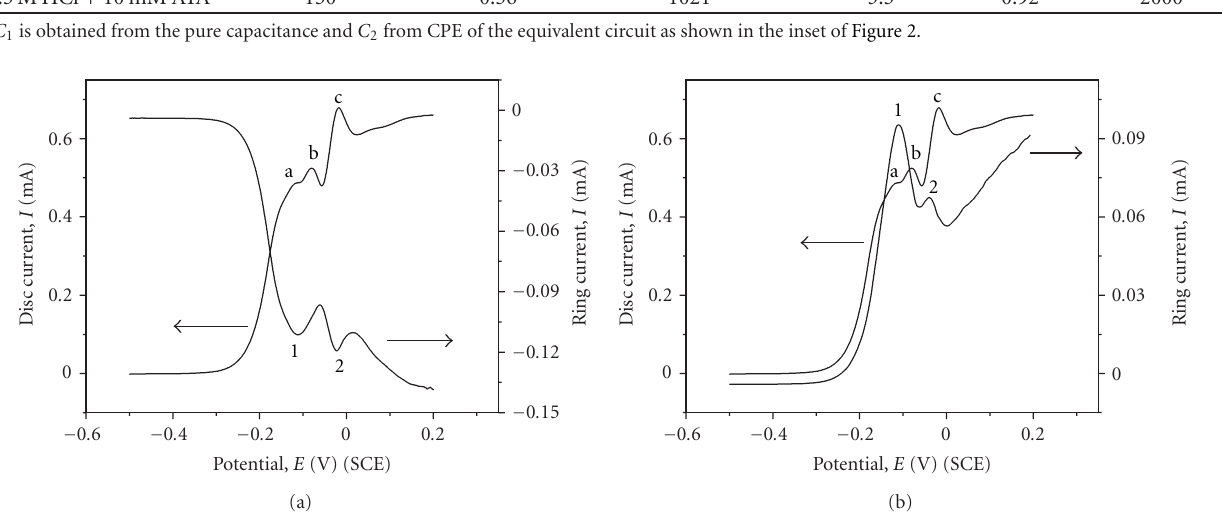
Figure 3: Rotating ring-disc voltammetry plots of copper disc electrode with Pt-ring electrode, (a) the ring electrode was made as a cathode; (b) the ring electrode was made as an